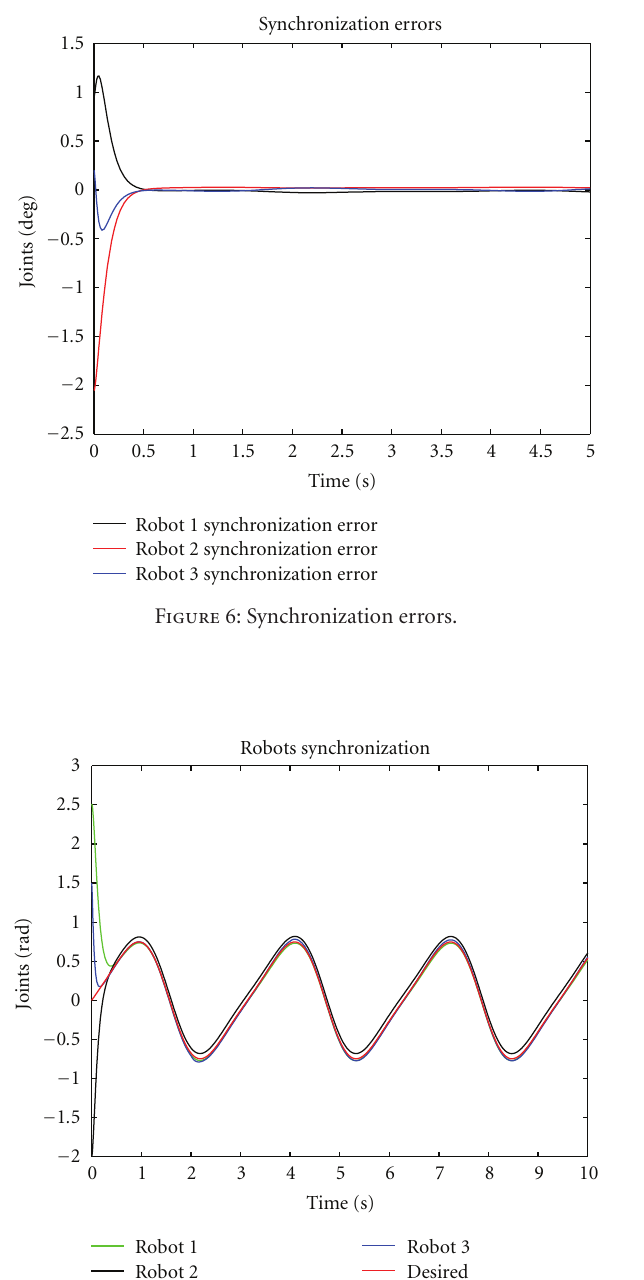
Figure 7: Robots synchronization without communication delay.